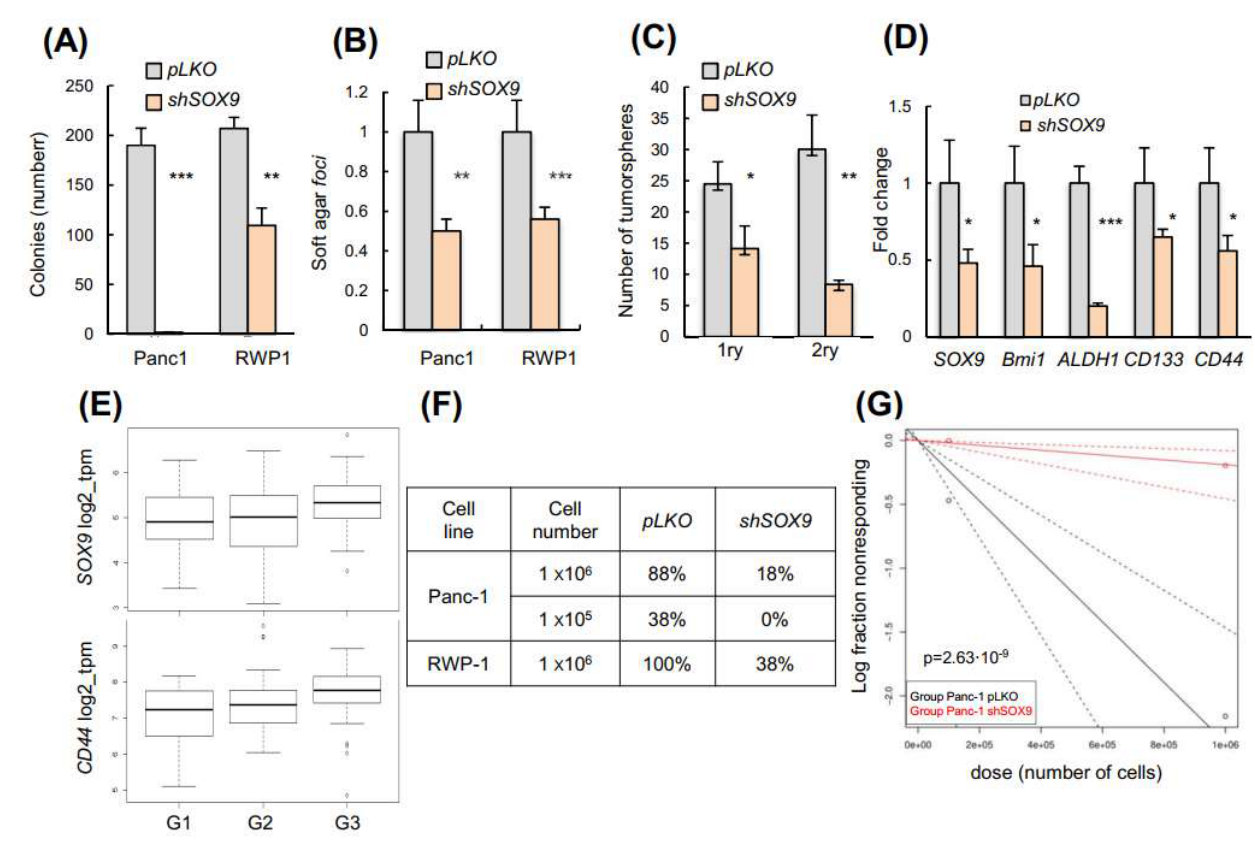
Figure 4. SOX9 is necessary for pro-metastatic cancer self-renewal. ( A ) Number of colonies formed by Panc-1 and RWP-1 pLKO and sh1 ( n ≥ 4). ( B ) Relative number of soft agar foci formed by Panc-1 and RWP-1 sh1 cells ( n = 4). ( C ) Representative image and quantification of the number of primary (1ry) and secondary (2ry) tumorspheres formed by control and sh1 RWP-1 cells ( n = 6). ( D ) mRNA levels of cancer stem cell markers in 2ry tumorspheres ( n = 4). ( E ) SOX9 and CD44 expression according to tumor grade in pancreatic cancer samples from the TCGA cohort (SOX9: p = 0.0289, n = 147; CD44: p = 0.0038, n = 147). ( F ) Tumor incidence in nude mice injected with Panc-1 and RWP-1 pLKO and sh1 cells. ( G ) Plot representing the fraction of mice without tumors with respect to the dose of Panc1 cells subcutaneously injected. The slopes of the depicted solid lines correspond to the fraction of cells with tumor-initiating ability (black color: pLKO cells; red color: sh1 cells. Chi square test for differences in stem cell frequencies: p = 2.63× 10 -9 . Analysis performed using the ELDA software application (http://bioinf.wehi.edu.au/software/elda/). Accessed on 6th September 2021. Asterisks (*, **, and ***) indicate statistical significance ( p < 0.05, p < 0.01, and p < 0.001, respectively).